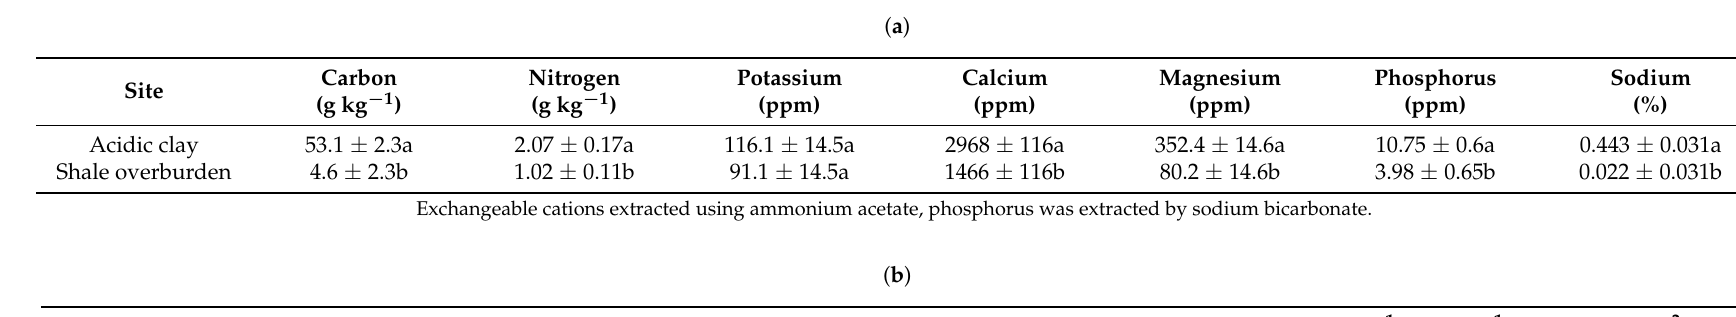
Table 2. ( a , b ) Soil properties (Mean ± SE) from two sites, an acidic clay deposit and a shale rock overburden, at the Salmon Harbour mine site. Sites with different letters are significantly different at p =